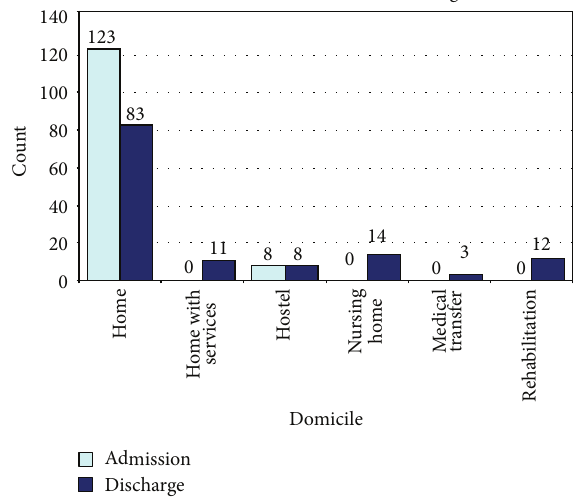
Figure 2: Overall patients’ domicile at admission and